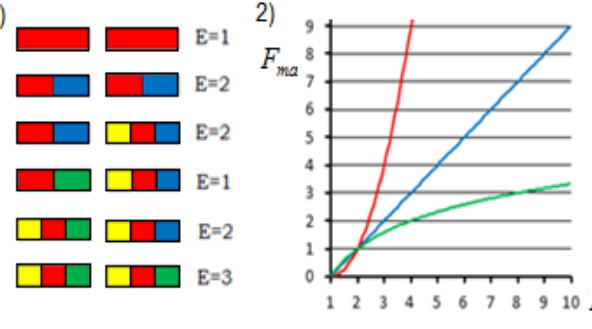
Fig. 7. Calculation of E and F ma